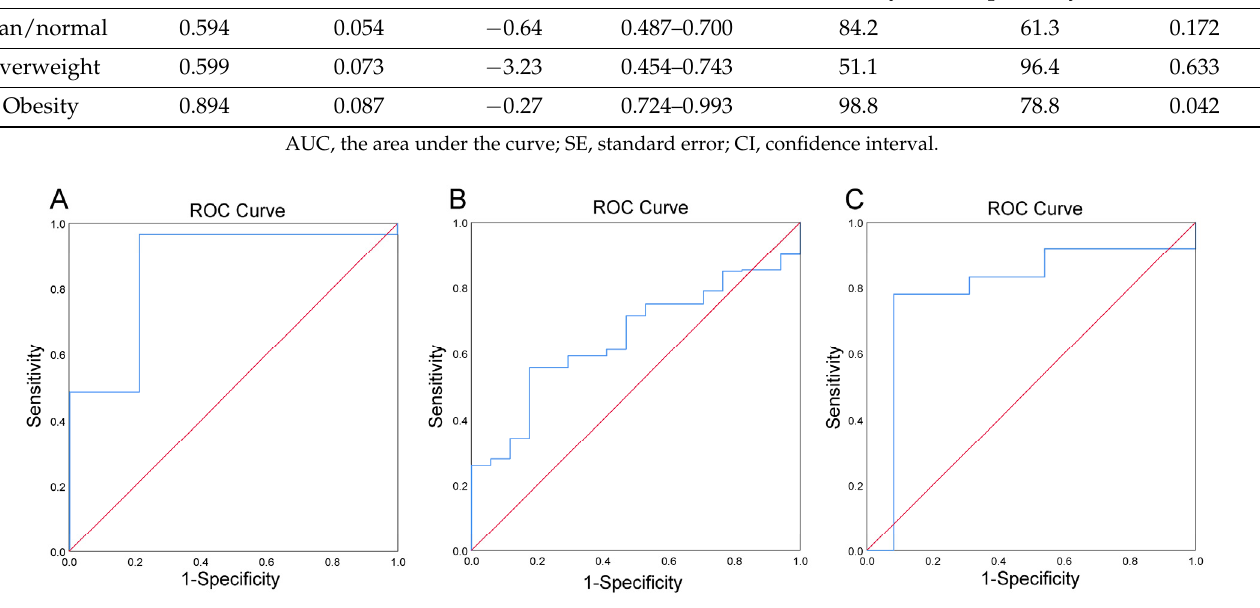
Figure 5. Predictive potential of Log( P/B ), as estimated using the receiver operating characteristic (ROC) analysis for LL of whole blood iron in obesity group ( A ) HL of whole blood iron in lean/normal group ( B ), and HL of whole blood iron in overweight group ( C ). Table 6. Predictive Log( P/B ) performance in HL of whole blood iron among infertile lean/normal, overweight, and obese patients,